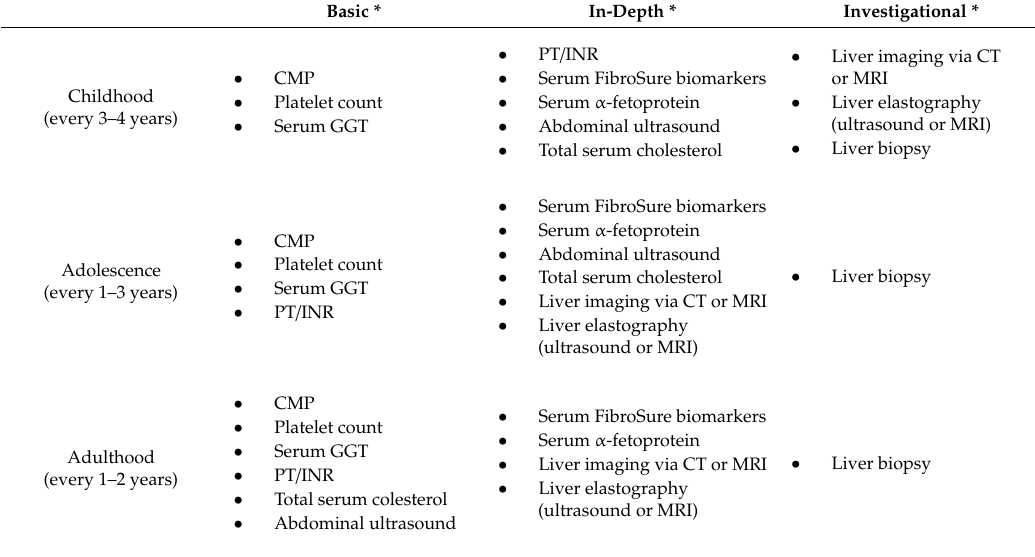
Table 1. Tests recommended by the American Heart Association for surveillance of liver disease in post-Fontan